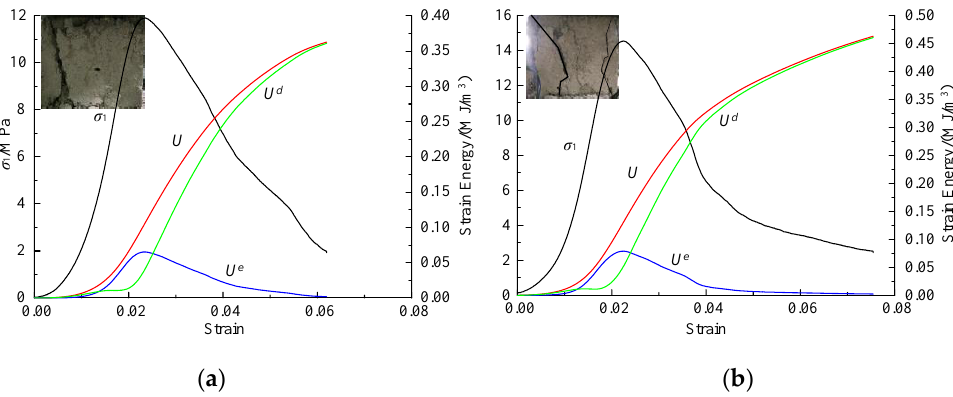
Figure 6. Stress and energy with strain for cement mortar samples: ( a ) B-1.0–3; ( b ) C-1.0–1.